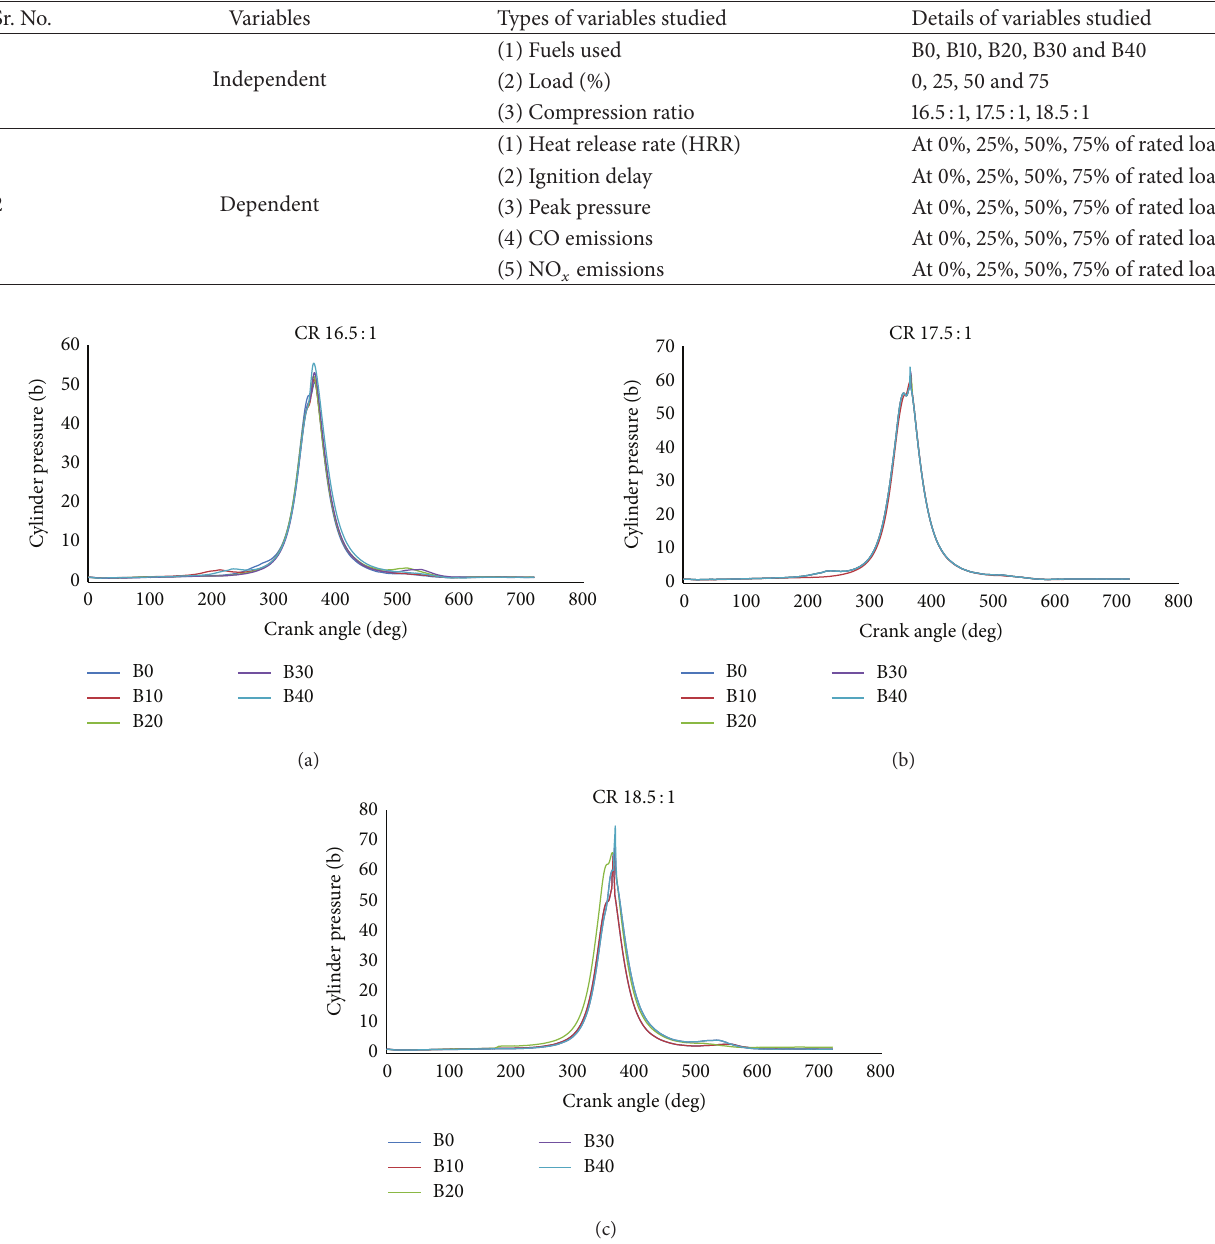
Table 3: Test matrix for combustion and emissions study on diesel engine. Sr. No.